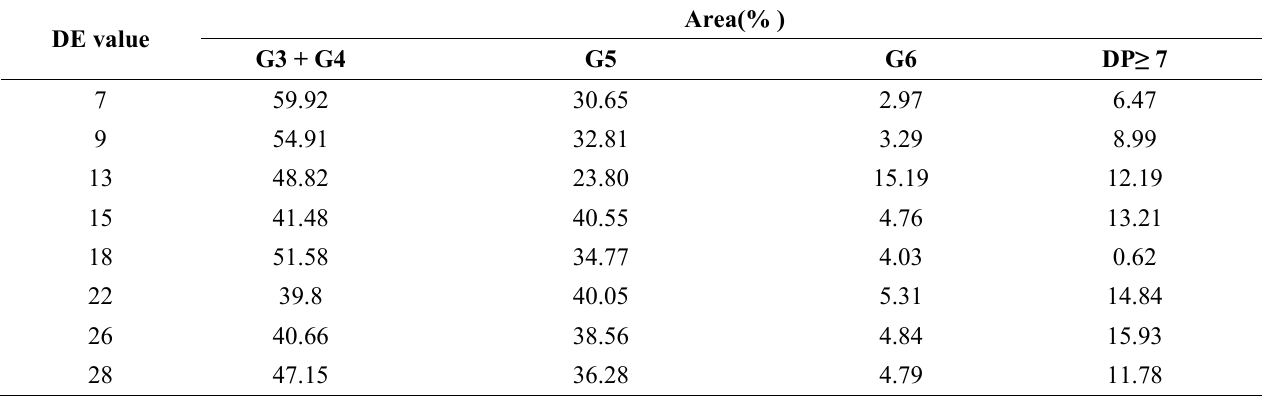
Table 2. Proportion of sugar of dextrins with different DE